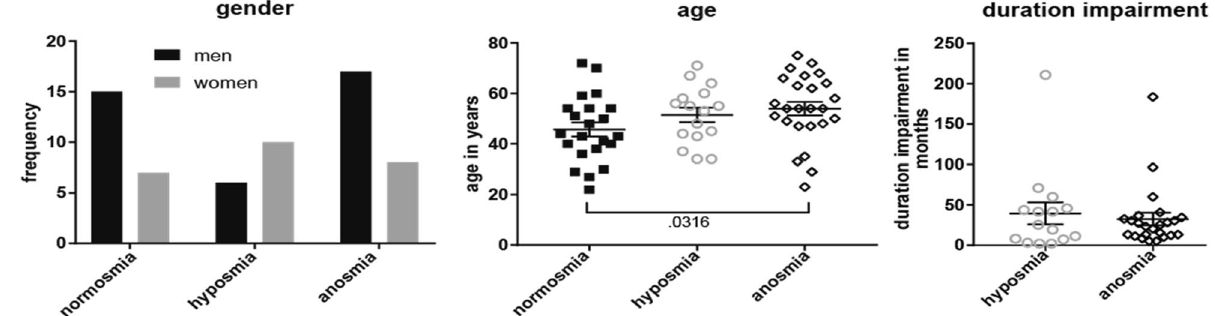
Figure 1. Participant gender and age by group. Left panel shows a histogram of men (solid black bars) and women (solid gray bars) count. Center panel shows mean (center line) age with standard error of the mean bars (shorter upper and lower bars), with individual data points overlaid for normosmia (solid black squares), hyposmia (open gray circles), and functional anosmia (open black diamonds) participant groups. Right panel shows the duration of olfactory impairment in months, showing the relevant hyposmia and anosmia groups only. Bracket indicates significant post-hoc t test between groups (corrected for multiple comparisons) with p